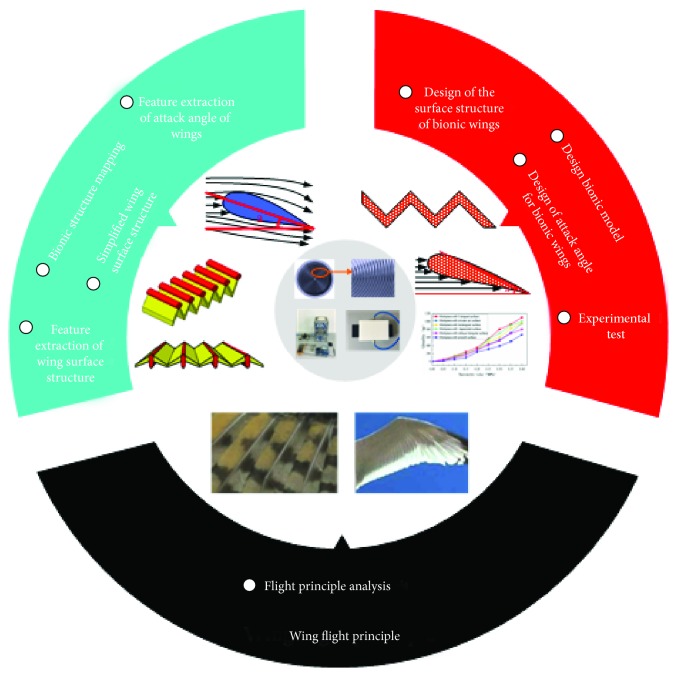
Technical route.